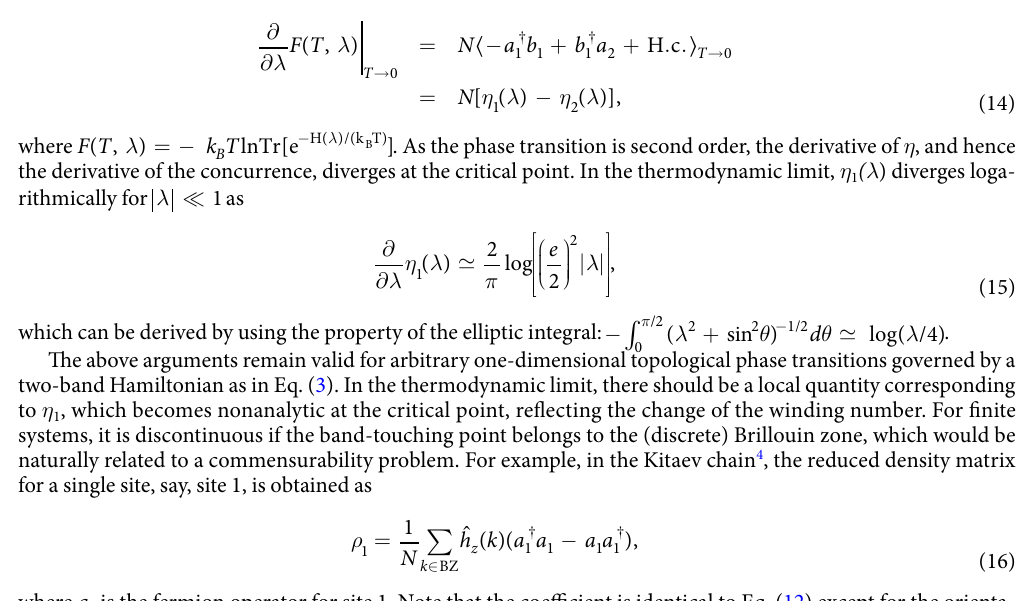
Figure 4. ( a ) Different behaviour of  λ ( ) according to the parity of N .  λ ( ) 2 point for even N .  λ λ d d ( )/ for ( b ) even N and ( c ) odd N . ( d ) Typical behaviour of  λ ( ) 2 small disorder. ( e )  λ λ d d ( )/ at the centre of the chain in the case of the open boundary 2